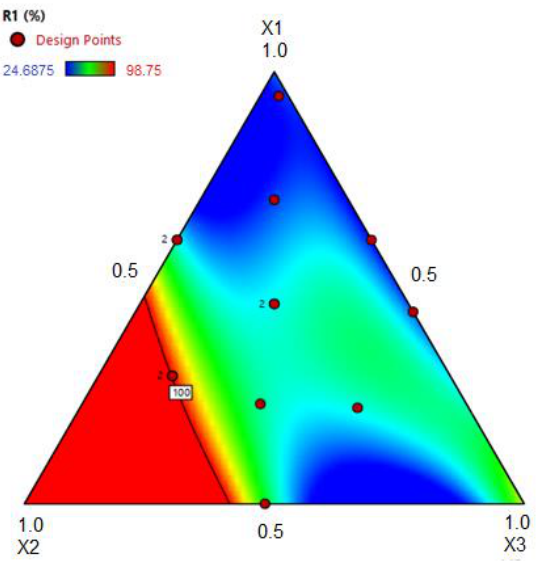
Figure 2. Triangular surface response for inhibition of mycelial growth (R1 %) as a function of the amount of cocoa butter ( X1 ), Palmarosa essential oil:sesame oil ( X2 ), and Phospholipon 80H ® ( X3 ) given in pseudocomponents.